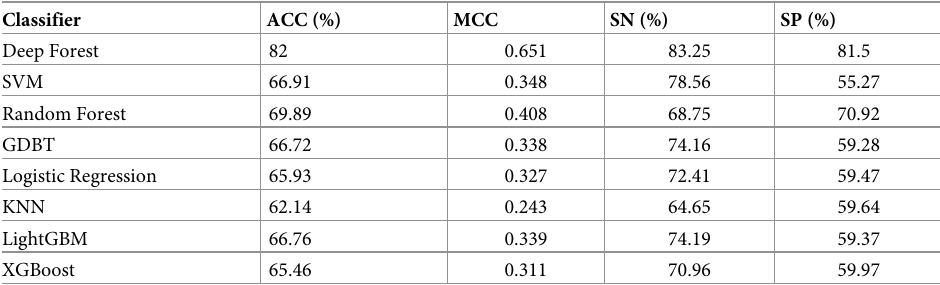
Table 1. Results for each base classifier on the training set assessed by four